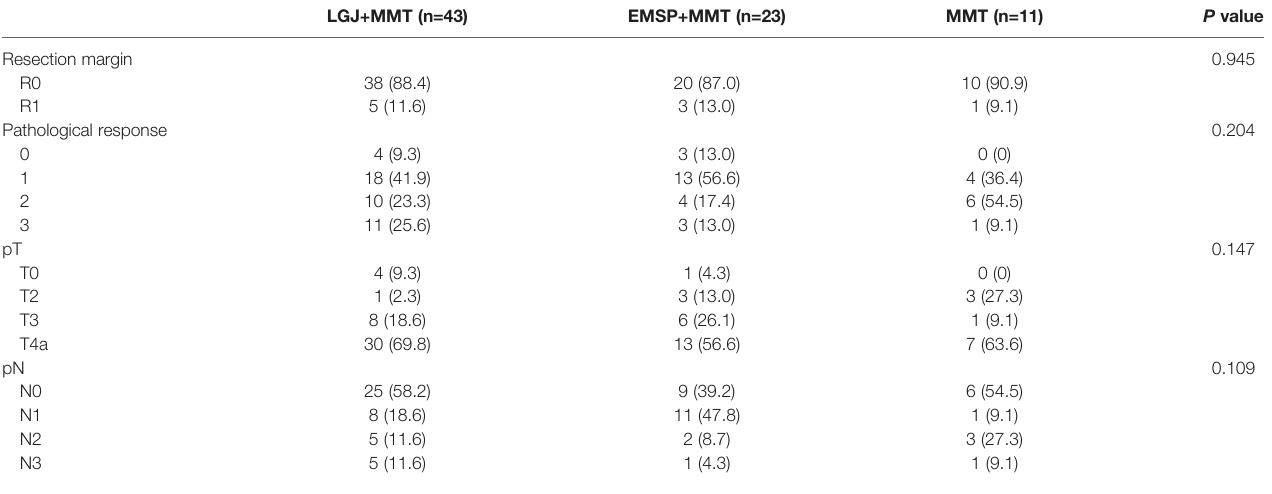
TABLE 3 | Surgical and pathological fi ndings after treatments